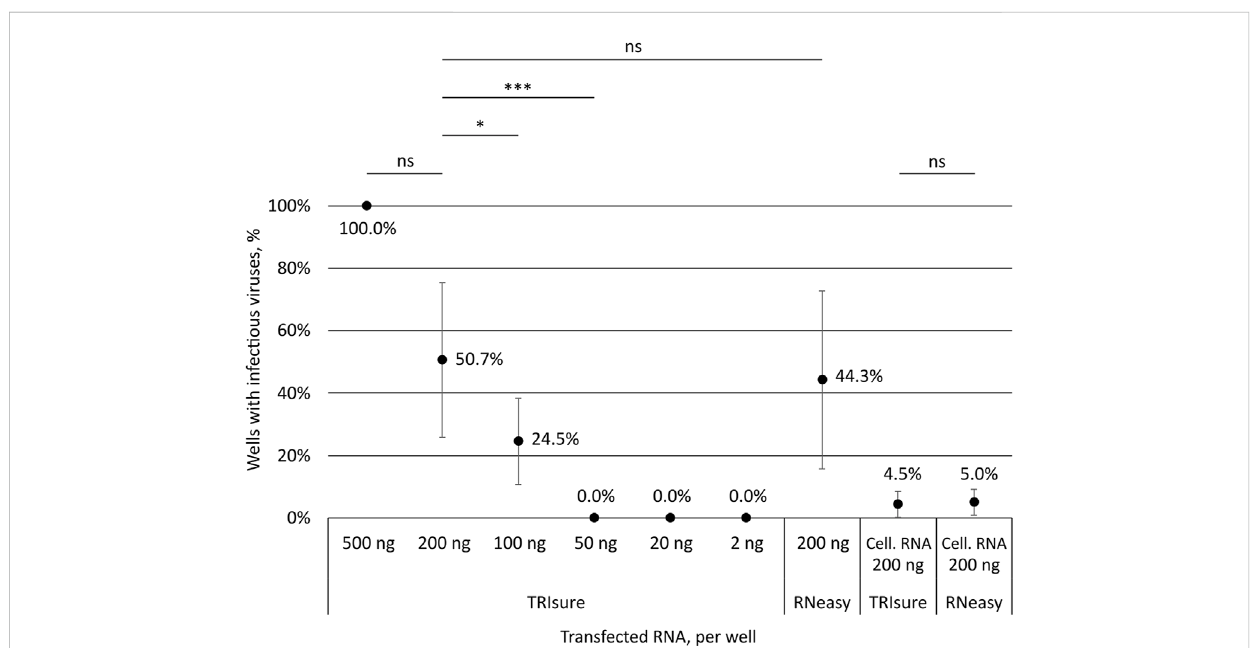
FIGURE 2 CorrelationofthetransfectedRNAamounttotheproductionofinfectiousviruses.DifferentamountsofSARS-CoV-2vRNA(concentratedgenomic vRNA or total cellular RNA from virus-infected cells) were transfected into VeroE6-TMPRSS2 cells and the formation of CPE by infectious viruses was monitored. The presence or lack of infectious viruses was con fi rmed by an endpoint dilution assay. The graph shows the percentage of wells with an infection after transfection (both CPE and TCID 50 titer positive). The means and standard errors of the means have been calculated from the following number of experiments (the total number of replicates in parenthesis): 500 ng, 1 (3); 200 ng, 10 (63); 100 ng, 5 (39); 50 ng, 2 (15); 20 ng, 3 (30); 2 ng, 3 (30); 200 ng kit, 7 (58); Cell. RNA, TRIsure, 5 (46); Cell. RNA, RNeasy, 2 (20). Cell. RNA, total cellular RNA from virus-infected cells; TRIsure, RNA extracted with TRIsure reagent; RNeasy, RNA extracted with RNeasy Mini kit. p < 0.05 (*), p < 0.001 (***), not signi fi cant (ns).